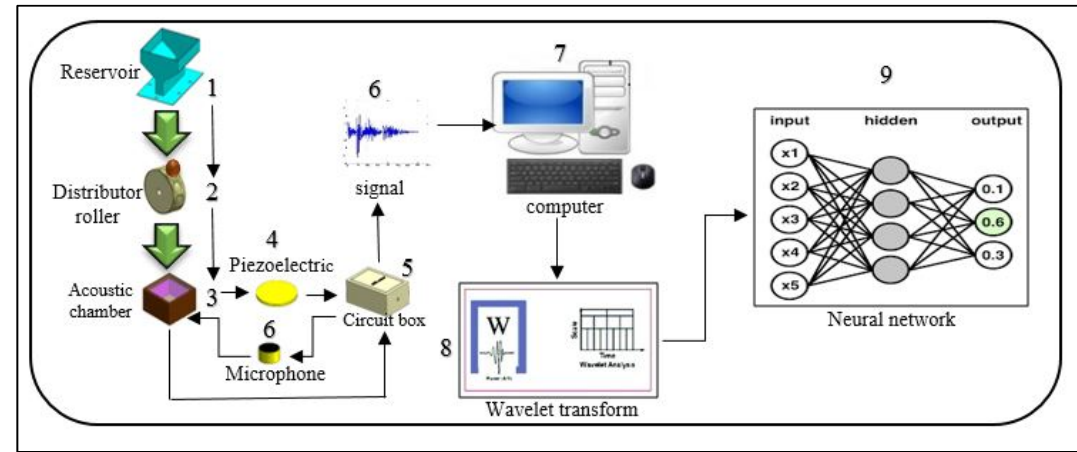
Figure 1. schematic of the system. Figure 1. Schematic of the